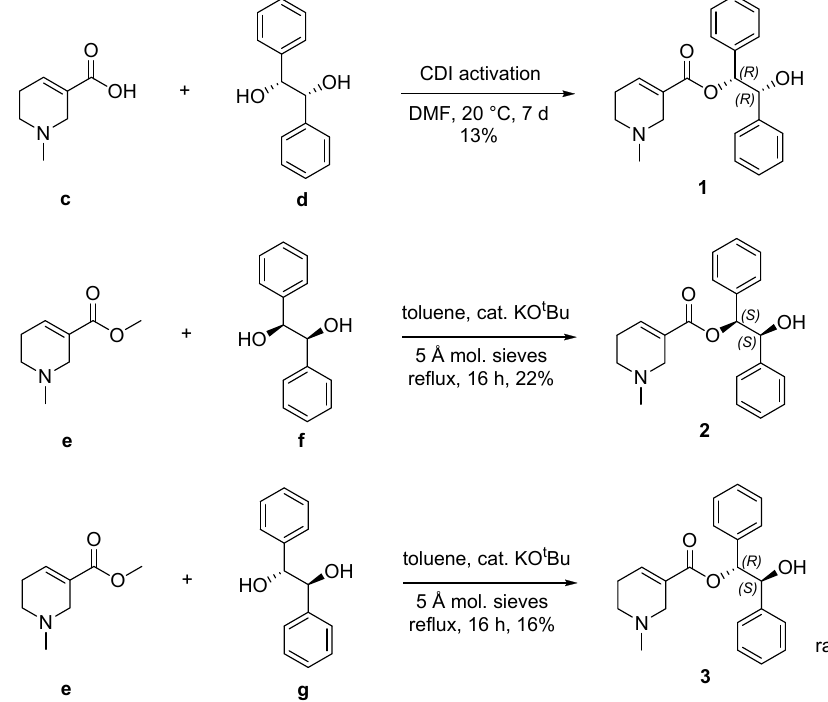
Figure 2. Stereoselective synthesis of hydrobenzoin esters of arecaidine.